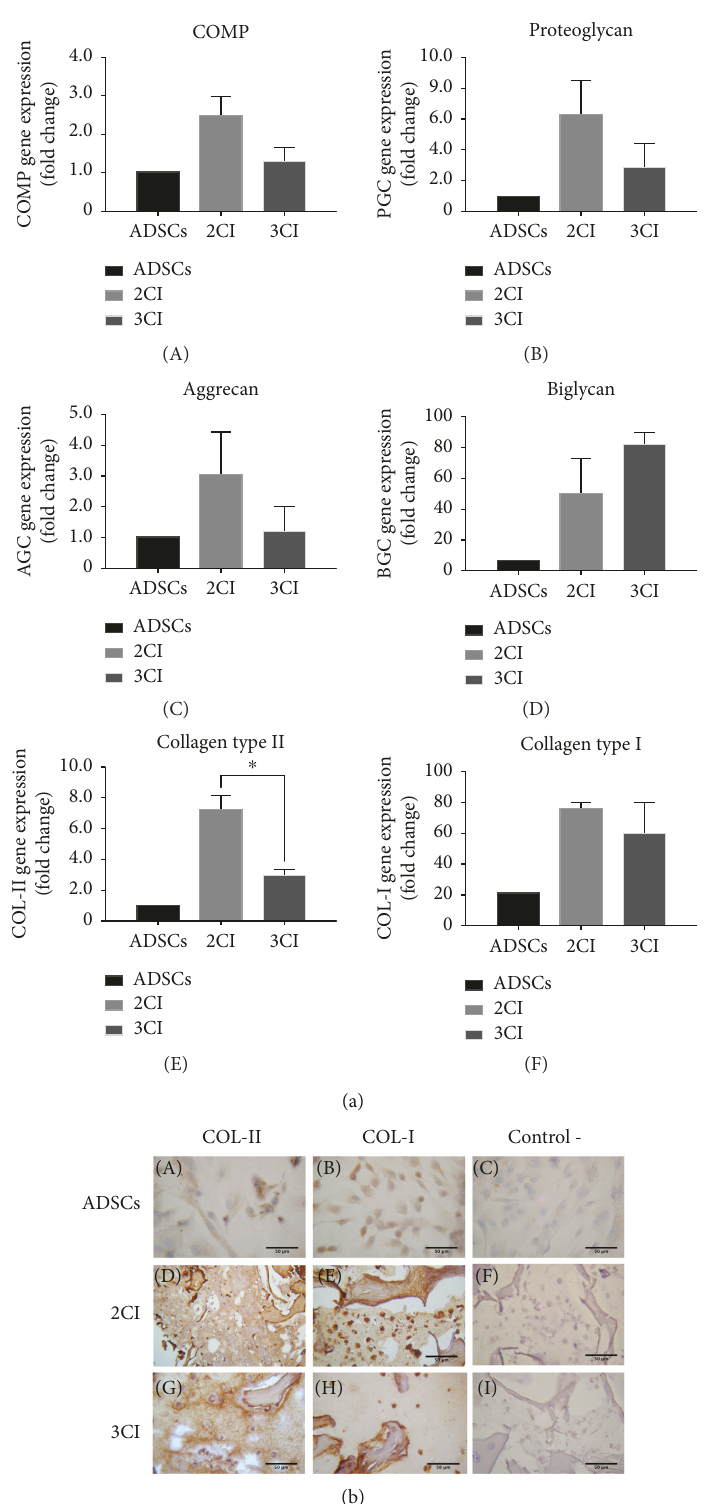
Figure 6: Expression analysis of chondrogenic di ff erentiation markers in the 3CI and 2CI implants. (a) Relative gene expression of (A) COMP, (B) proteoglycan, (C) aggrecan, (D) biglycan, (E) collagen II, and (F) collagen I in ADSCs and in 2CI and 3CI groups. Data are reported as mean ± standard deviation ( n = 3 ). A signi fi cant di ff erence was observed for collagen II in the implant 2CI compared with 3CI ( ∗ p < 0 05 ). (b) Representative images at day 28 for type II and type I collagen immunohistochemistry. ADSCs: adipose-derived mesenchymal stem cells cultured in a monolayer. 2CI and 3CI showed positive staining for type II collagen and strong signal for type I collagen as well. Negative controls were treated with PBS without primary antibodies. Scale bar =50 μ